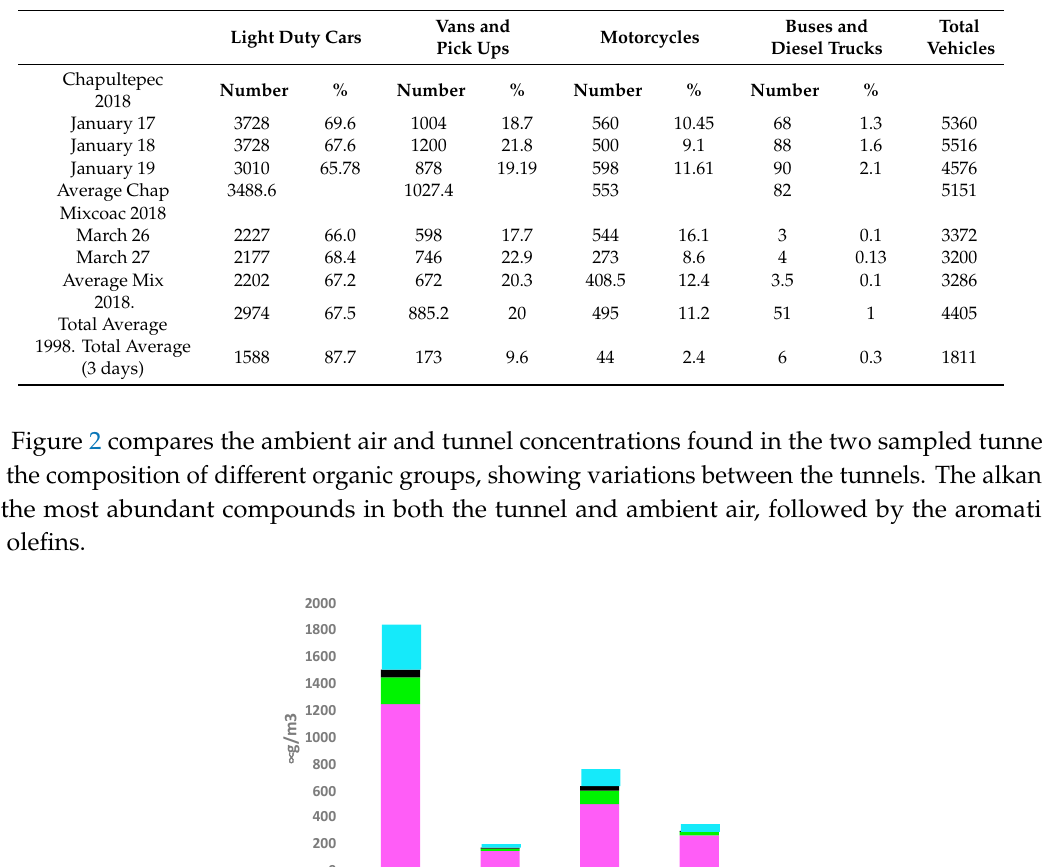
Table 1. Characteristics of the vehicular fleet.